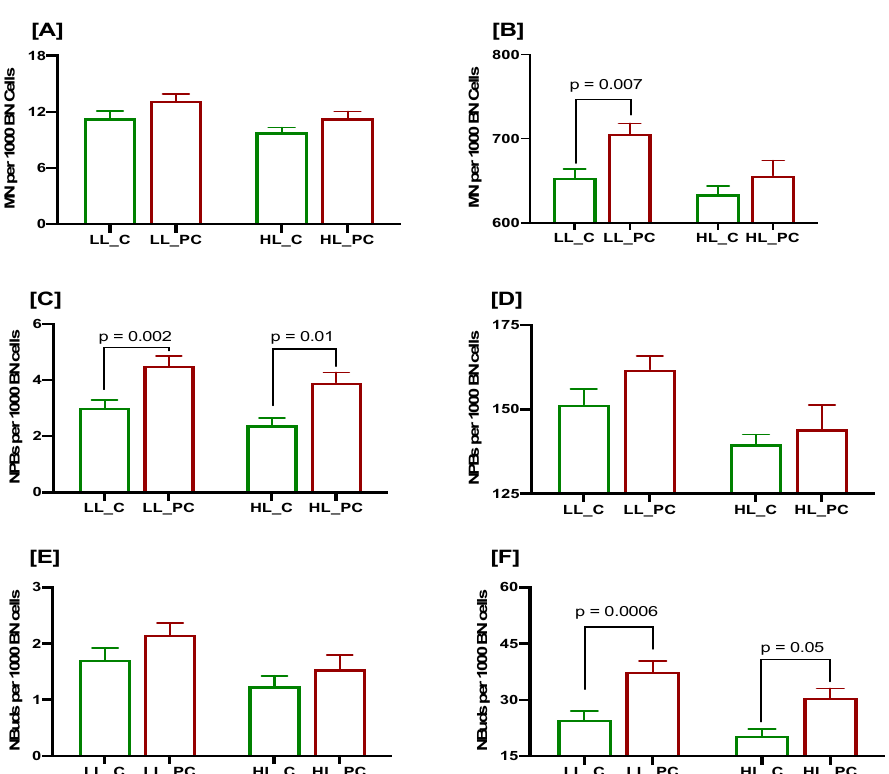
Figure 3. CBMN Cytome assay biomarkers in PC patients (red bars) and age-matched healthy controls (green bars) stratified as per lycopene concentration (LL: low lycopene; HL: high lycopene); MN frequency at baseline ( A ) and after 3 Gy irradiation ( B ); NPBs at baseline ( C ) and after 3 Gy irradiation ( D ); NBuds at baseline ( E ) and after 3 Gy irradiation ( F ). N = 61, 67, 71 and 36, respectively, from left to right for each bar. p values are only indicated for those comparisons that are